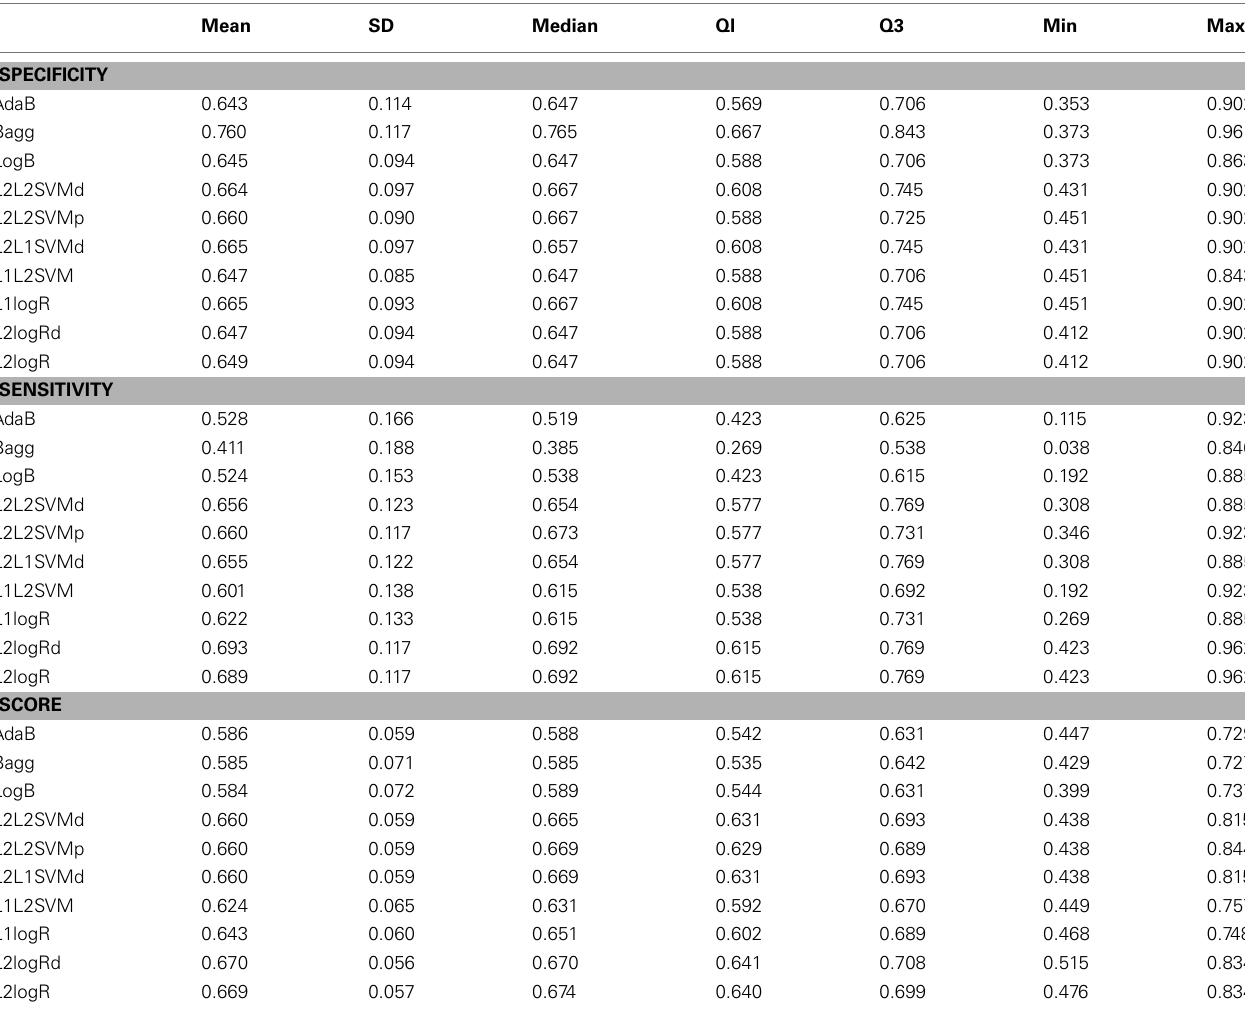
TableA2 | Descriptive statistics of the performance measures in combined vs. inattentiveADHD patients classification when using fALFF + REHO + RSN4